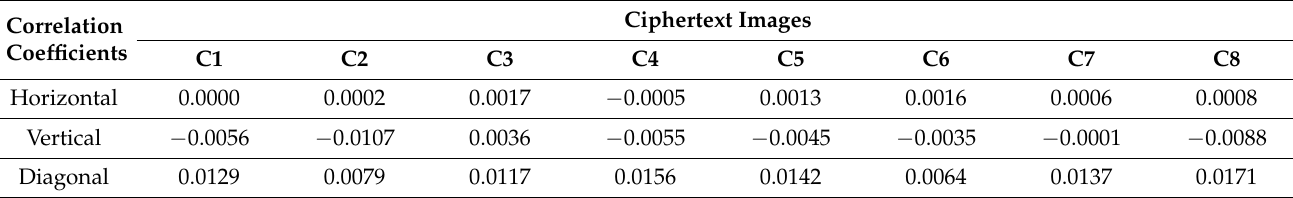
Table 2. Correlation coefficients of adjacent pixels of ciphertext images.